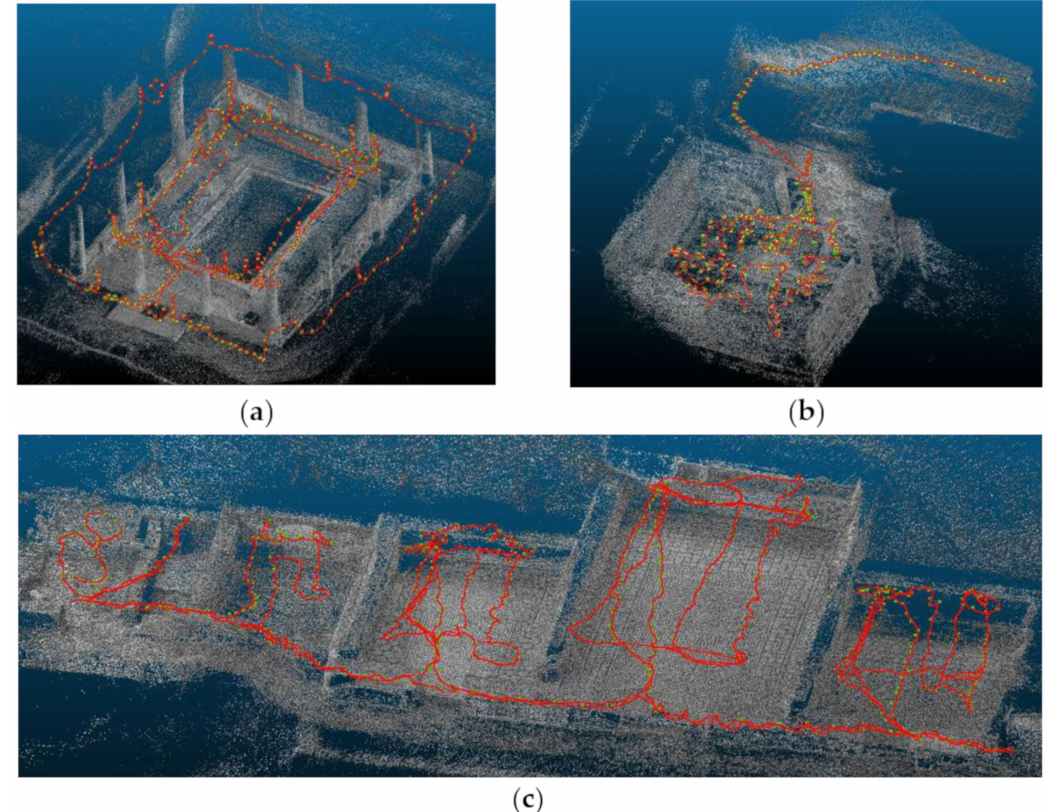
Figure 7. Trajectory followed (red lines) during data acquisition in the three work zones: orking area 1 ( a ); working area 2 ( b ); and working area 3 ( c